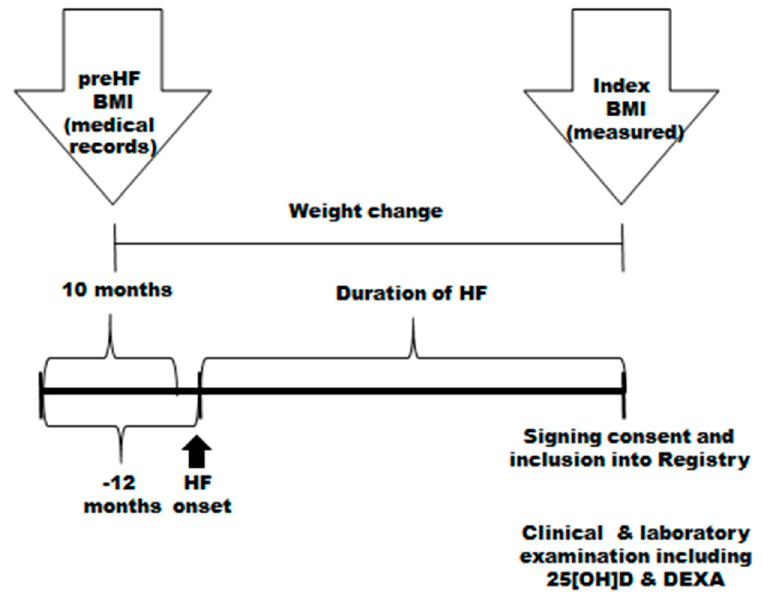
Figure 1. The time sequence of study procedures; BMI, body mass index; HF: heart failure.